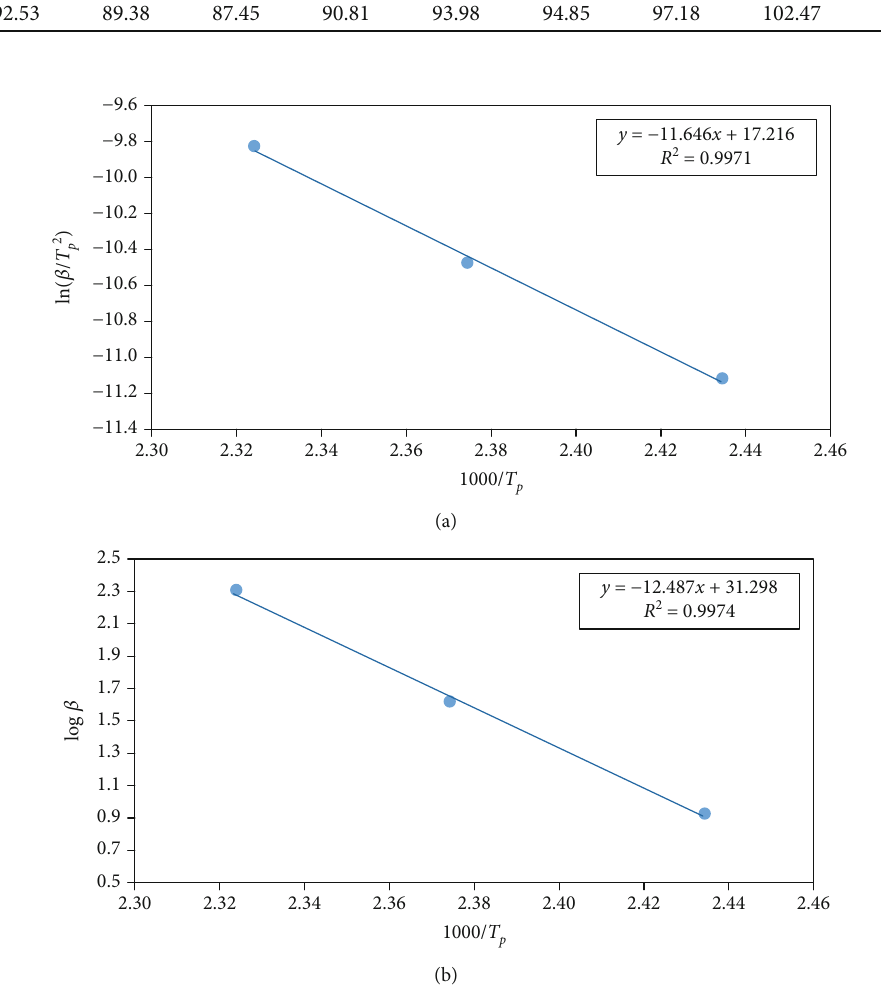
Figure 12: The plots obtained using (a) Kissinger and (b) Ozawa